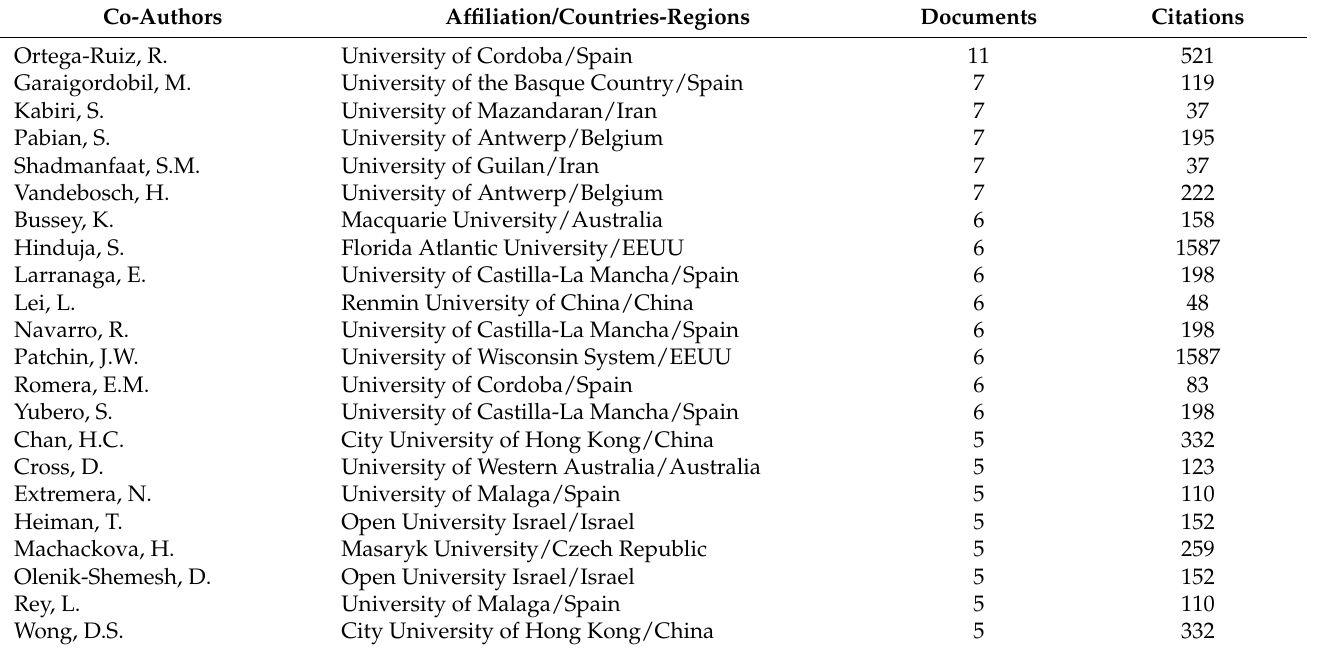
Table 3. Most prolific and prominent co-authors on Cyberbullying and Psychology of the Self.